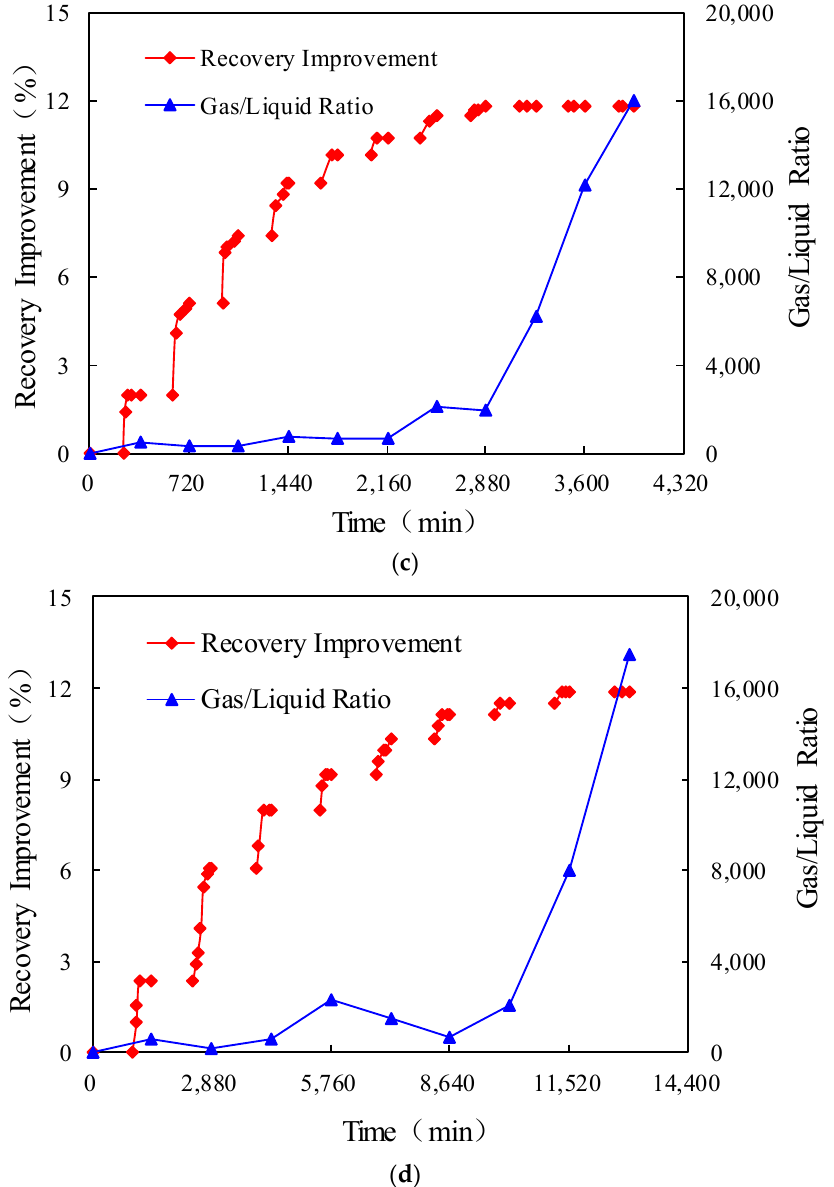
Figure 3. Production dynamics of different schemes for IGI. ( a ) Scheme JX-1. ( b ) Scheme JX-2. ( c ) Scheme JX-3. ( d ) Scheme JX-4 .